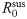
(A) Histogram of the posterior estimate of R0sus. (B) The 95% credible interval of R0res(π) against π with dashed lines showing the 95% credible interval for π{R0res=1}. (C) Histogram of the posterior estimate of π{R0sus=R0res}: the threshold of cefixime prescriptions above which R0res>R0sus.